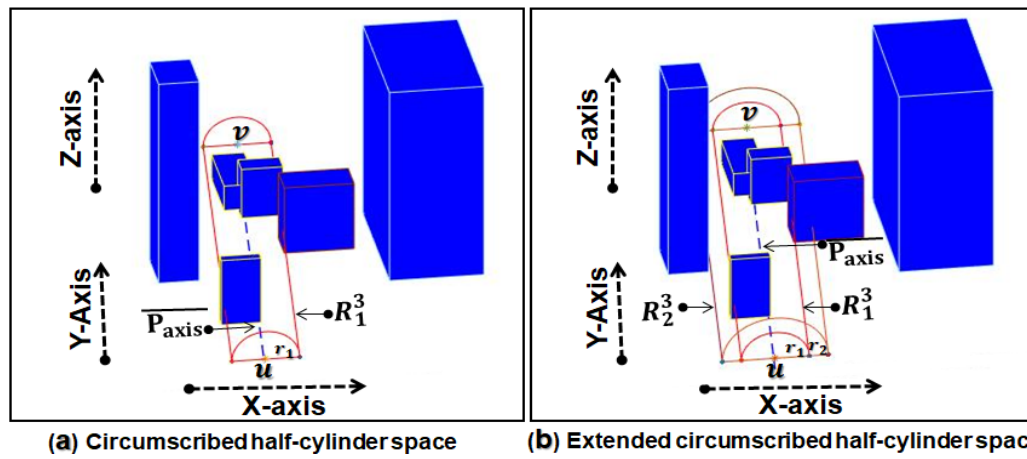
Figure 5. Circumscribed half-cylinder space ( R 3